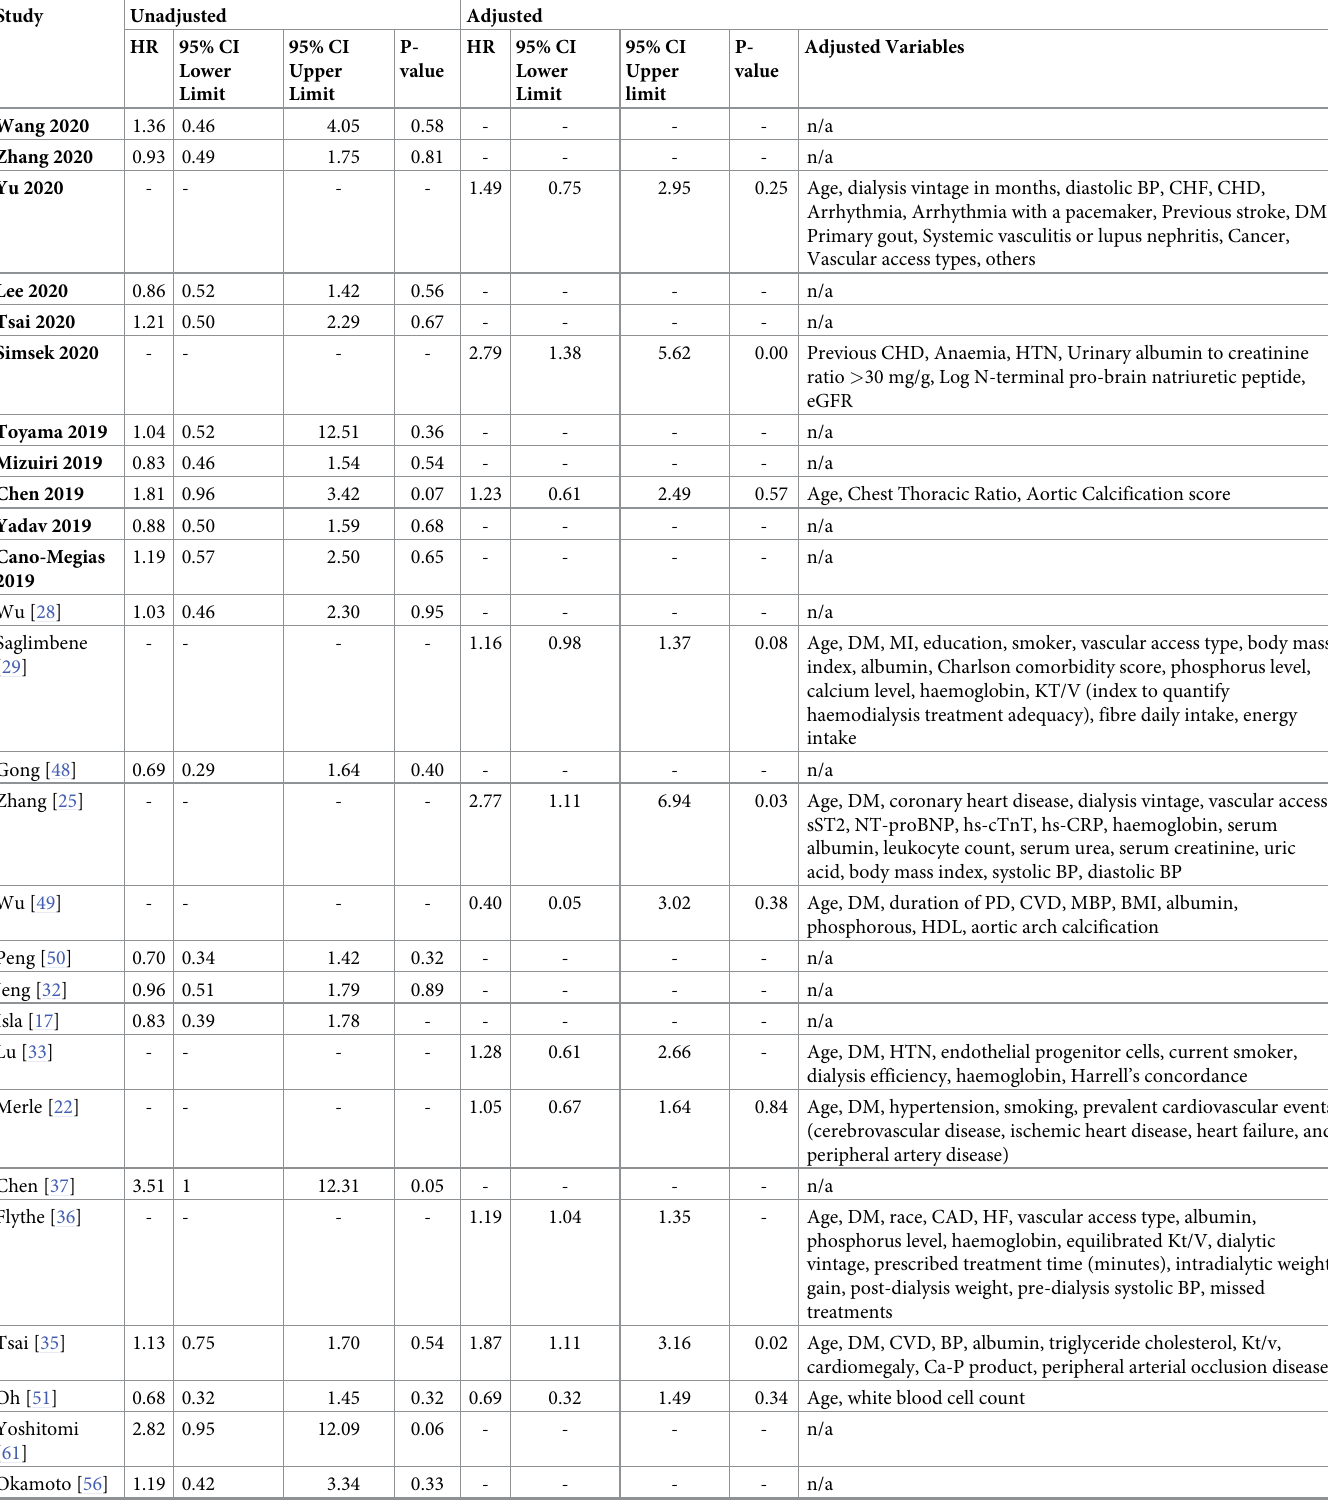
Table 2. Summary of reported risk estimates of male sex for cardiovascular